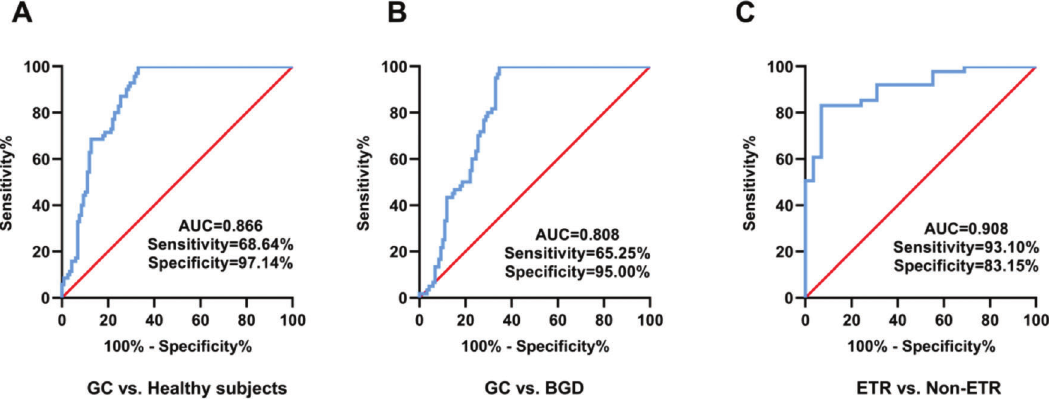
Figure 2 - The diagnostic performance of serum EV-miR-215-5p. (A) The diagnostic performance of serum EV-miR-215-5p for distinguishing GC patients from healthy donors. (B) The diagnostic performance of serum EV-miR-215-5p for distinguishing GC patients from BGD patients. (C) The diagnostic performance of serum EV-miR-215-5p for identifying GC patients with ETR from those without